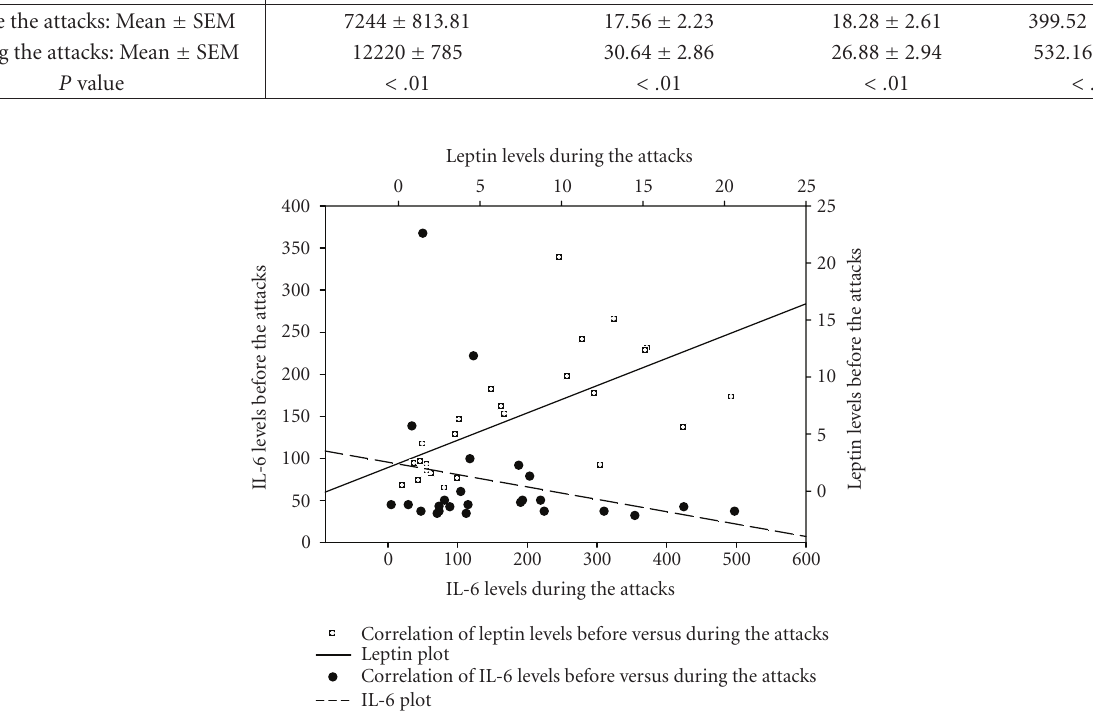
Figure 2: Correlation plot of leptin before and during FMF attacks together with IL-6 plot. Although serum leptin levels increased to some extent during the attacks, it was not statistical significant ( P > . 05). Serum IL-6 levels increased from 70 . 18 ± 14 . 8 (Mean ± SEM) to 163 . 32 ± 25 . 25 (Mean ± SEM) and they were statistically significant ( P < .